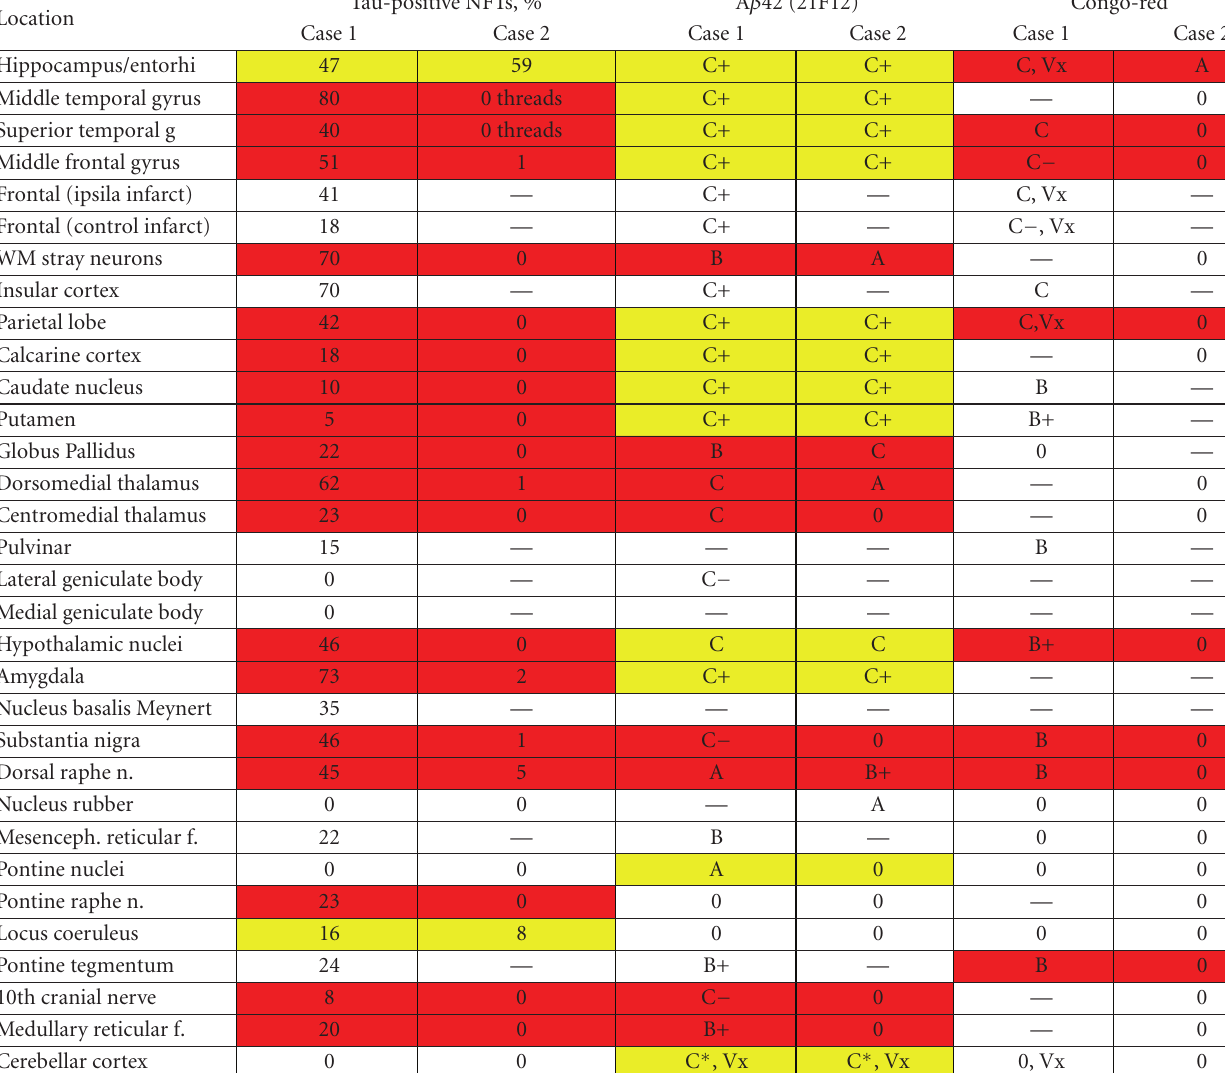
Table 1: Semiquantitative assessment of AD